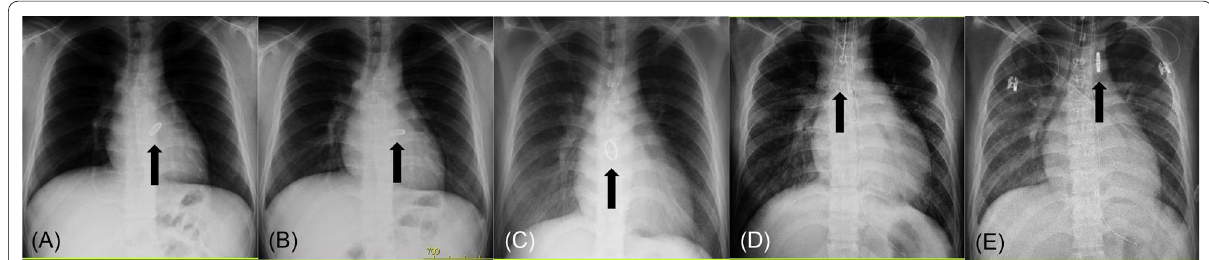
Fig. 1 Chest X-ray findings 3 months ago ( A ), 1 week ago ( B ), at emergent admission to the regional hospital ( C ), at leaving for our hospital ( D ), and at arriving at our hospital ( E ). Black arrows indicating mechanical valve